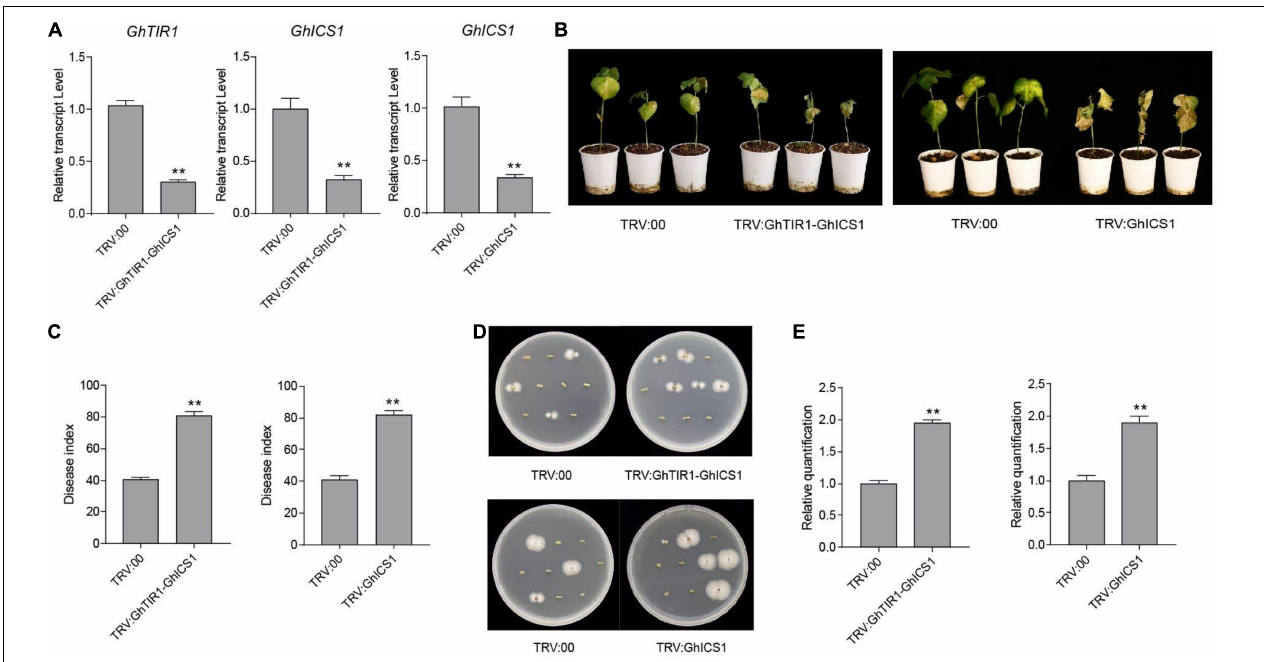
FIGURE 9 | Simultaneous knockdown of GhTIR1 and GhICS1 reduced plant resistance to Verticillium dahliae . (A) Relative expression of GhTIR1 and GhICS1 in TRV:GhTIR1-GhICS1 and relative expression of GhICS1 in the TRV:GhICS1 plants compared to TRV:00. (B) Disease symptom phenotypes of the TRV:GhTIR1-GhICS1 and TRV:GhICS1 plants and the control at 21 dpi. (C) Disease index at 21 dpi. (D) Fungal recovery assay. (E) Relative V. dahliae fungal biomass in the infected stems. Statistical significance was determined by Student’s t -test: ** P < 0.01. The error bars represent the standard error of the mean of three biological replicates.